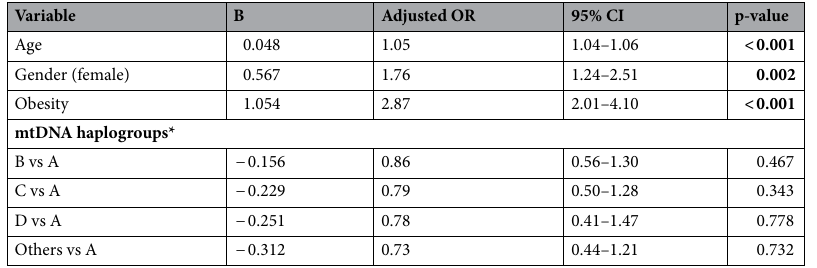
Table 3. Multivariate logistic regression model to predict the risk of knee OA (KL grade ≥ I) in Mexican population. B regression coefficient, OR odds ratio, CI confidence interval. *Statistical analyses were performed comparing the frequency distribution of each haplogroup with that of the most common haplogroup A (reference haplogroup). Statistical significance declared at p < 0.05 (in bold).